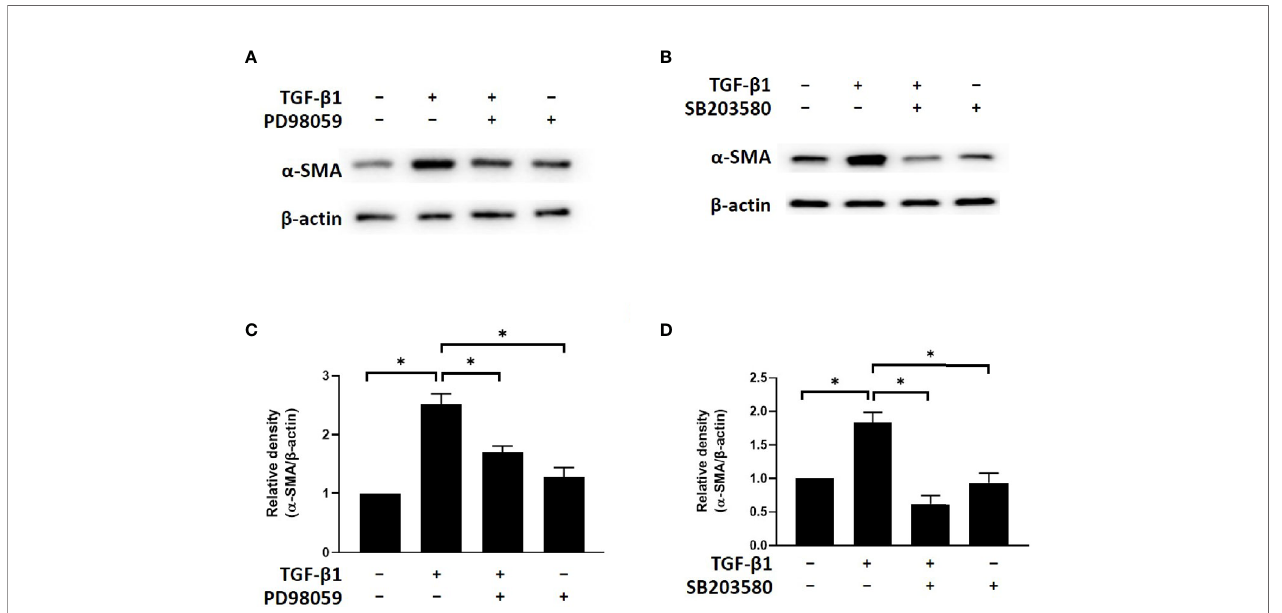
FIGURE 5 | Effects of ERK and p38 inhibitors on TGF- b -induced a -SMA expression in Graves ’ s ophthalmopathy (GO) orbital fi broblasts. Primary cultured GO orbital fi broblasts were stimulated with transforming growth factor- b (TGF- b 1) (3 ng/mL) for 48 h with or without a 1-h pretreatment with 10 m M of PD98059 (ERK inhibitor) (A, C) and 10 m M of SB203580 (p38 inhibitor) (B, D) . The protein levels of a -SMA were determined using western blot analysis. The densities of a -SMA protein bands were quanti fi ed and normalized to b -actin. Data are presented as mean ± SD of at least three independent experiments. *p <